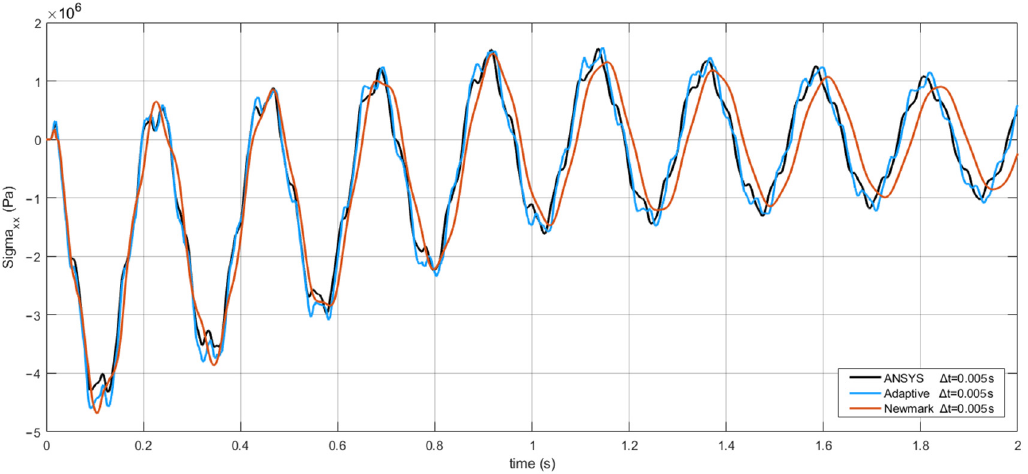
Figure 20. The normal stress σ xx at point B with damping coefficient c = 1 Ns/m and ∆ t = 0.005 s Figure 20. The normal stress 𝜎 (cid:3051)(cid:3051) at point B with damping coefficient 𝑐 = 1 Ns/m and Δ𝑡 = 0.005 s Figure 20. The normal stress 𝜎 (cid:3051)(cid:3051) at point B with damping coefficient 𝑐 = 1 Ns/m and Δ𝑡 = 0.005 s Figure 20. The normal stress 𝜎 (cid:3051)(cid:3051) at point B with damping coefficient 𝑐 = 1 Ns/m and Δ𝑡 = 0.005 s under Heaviside step loading with an infinite under Heaviside step loading with an infinite duration. under Heaviside step loading with an infinite duration. under Heaviside step loading with an infinite duration.